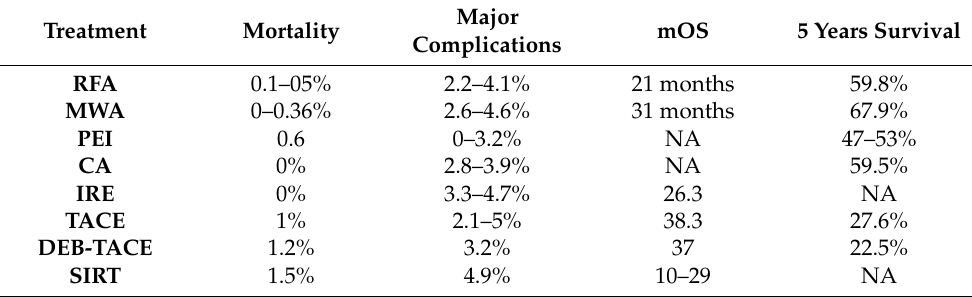
Table 2. Differences among locoregional therapies